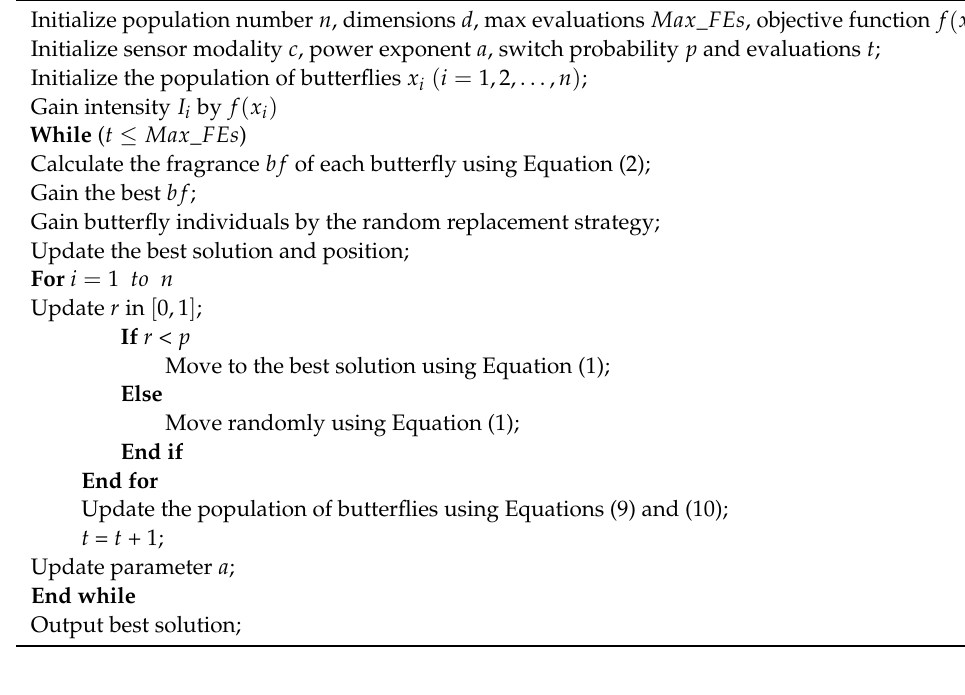
Algorithm 2: Pseudo-code of the